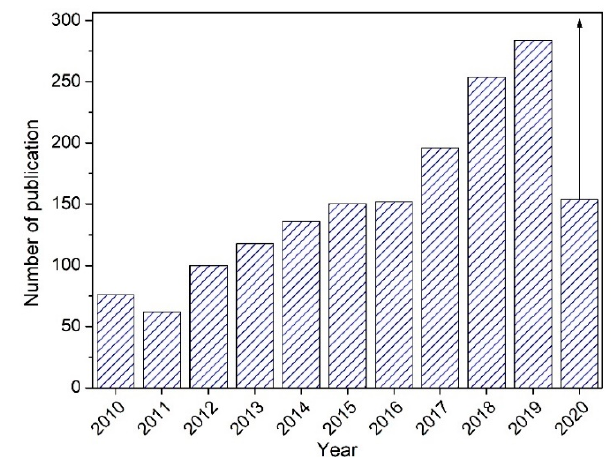
Figure 1. Publication trend in DED AISI 316L chronology between 2010 and 2020 in ScienceDirect (This graph is plotted according to a simple search of “316L” + “DED” at www.sciencedirect.com).